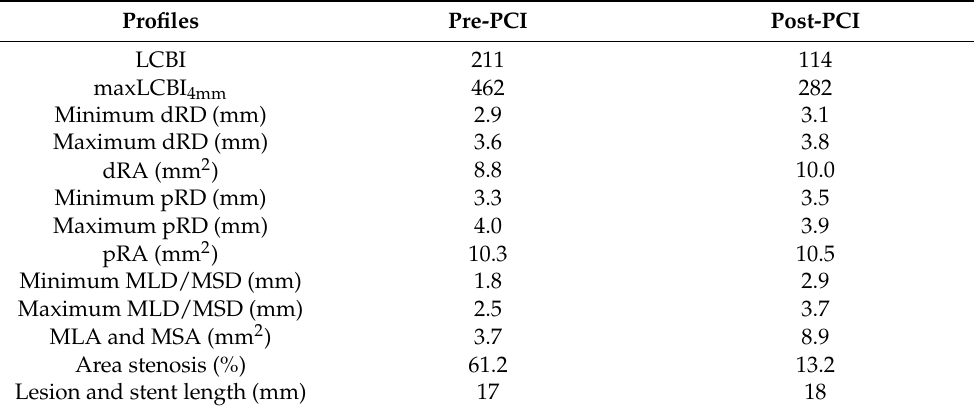
Table 1. Quantitative NIRS-IVUS profiles before and after